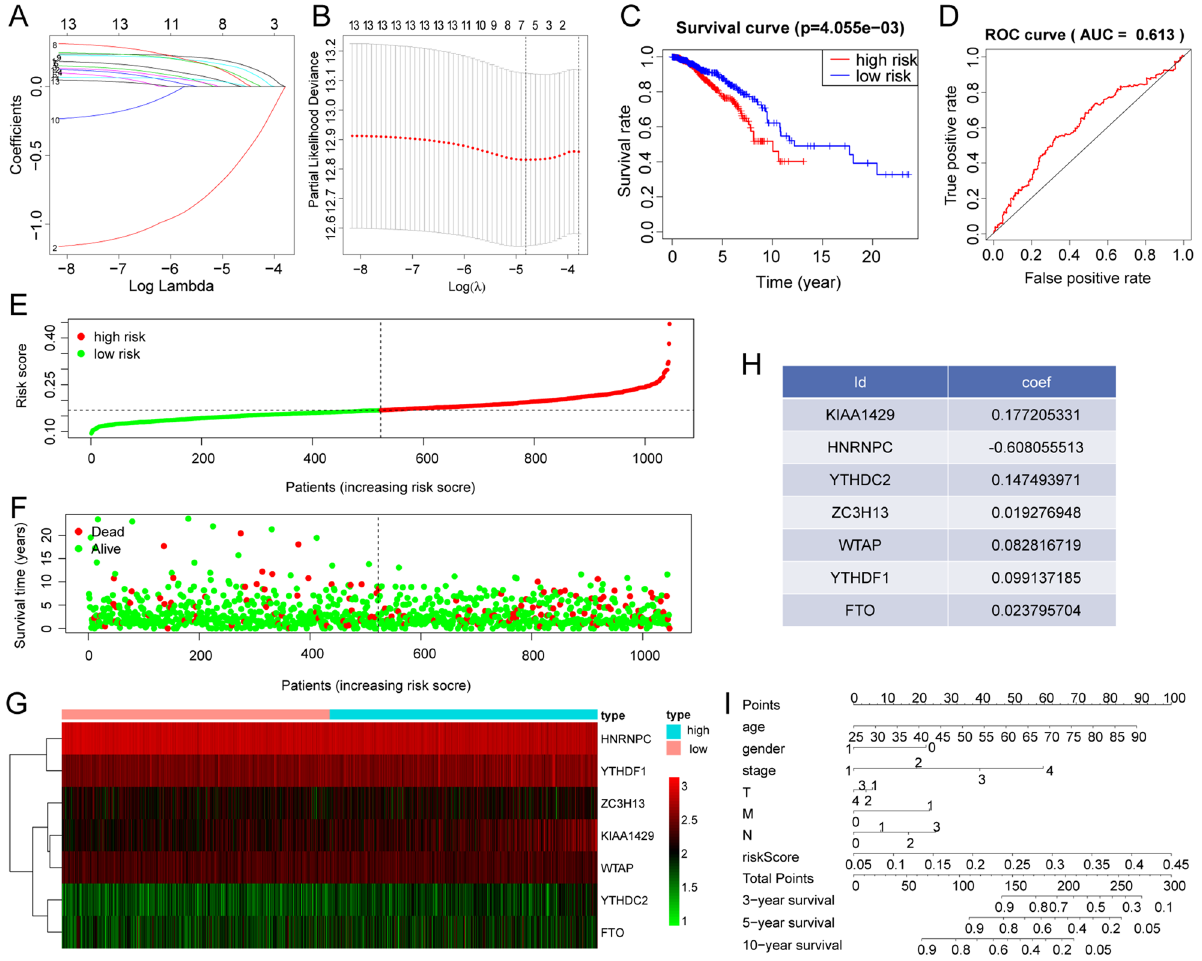
Figure 4. The m6A regulator prognostic model. ( A , B ) Identification of prognostic m6A regulator genes via LASSO cox regression analysis. ( A ) The ordinate shows the correlation coefficient, and the abscissa shows the penalty coefficient. ( B ) Partial likelihood bias of the LASSO coefficient distribution. The vertical dashed line indicates the minimum partial likelihood deviation. ( C ) The relationship between risk score and survival in breast cancer patients. Red represent high risk patients and blue represent low risk patients. ( D ) ROC curves showed the predictive efficiency of the risk score in breast cancer. ( E–G ) The distribution of risk score ( E ), patients’ survival status ( F ), and m6A regulators’ expression level ( G ) between high- and low-risk groups. High means high risk, and low means low risk. ( H ) The coefficient of seven prognostic m6A regulators. ( I ) A prognostic nomogram predicting 3-, 5-, and 10-year overall survival with breast